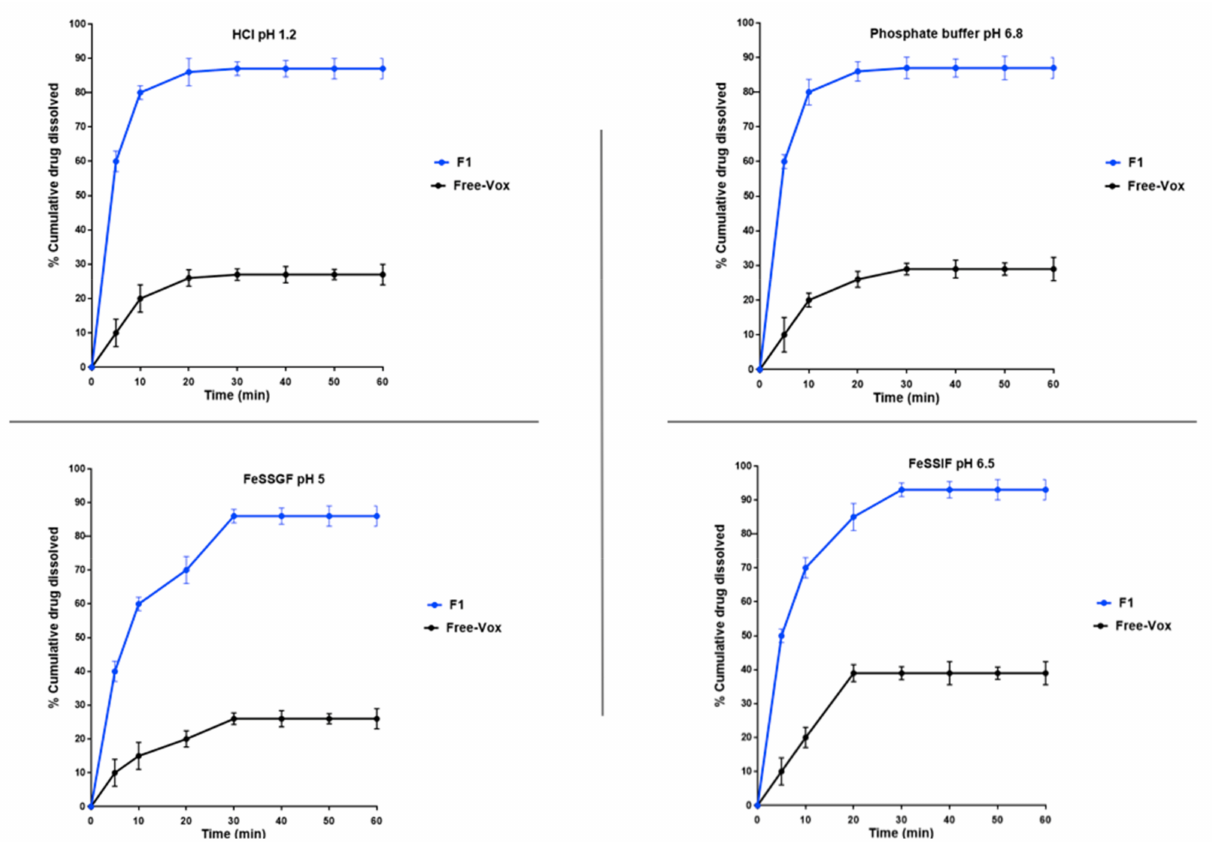
Figure 6. Dissolution profile of F1 and pure drug in various dissolution media using a paddle apparatus at 37 ± 0.5 ◦ C. Data are expressed as the mean ± SD, n = 3. FeSSGF—fed state simulated gastric fluid; FeSSIF—fed state simulated intestinal